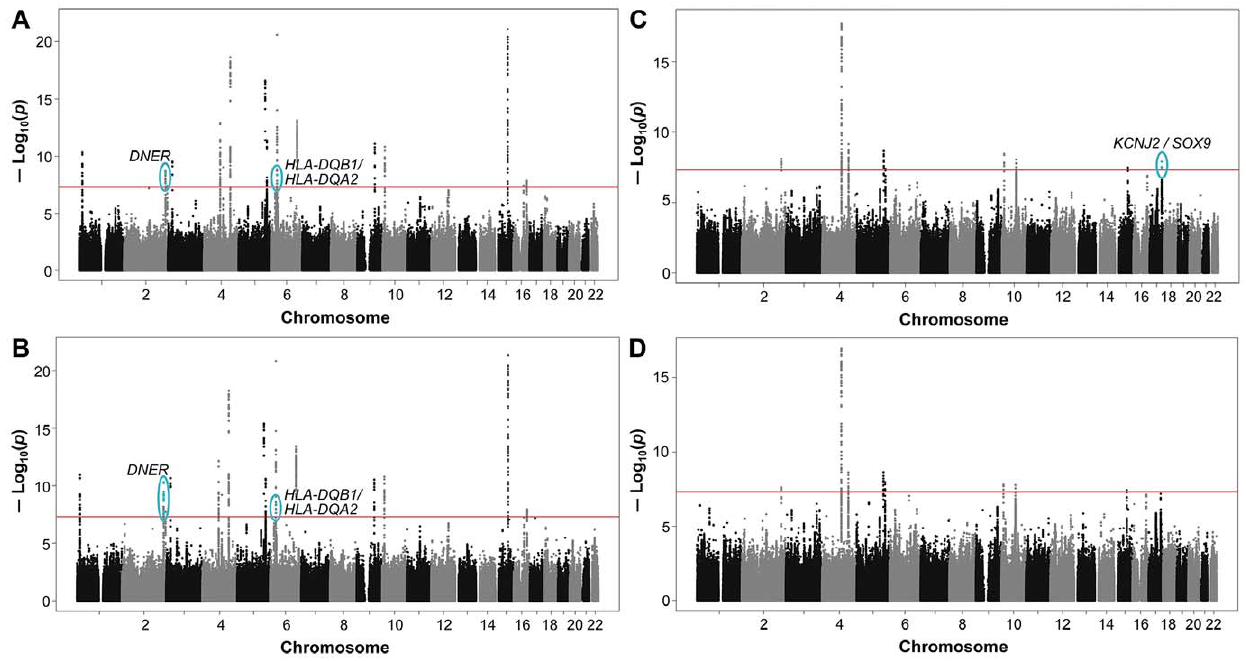
Figure 1. Genome-wide joint meta-analysis (JMA) of SNP and SNP-by-smoking interaction in relation to pulmonary function. The Manhattan plots show the chromosomal position of SNPs in comparison to their 2 log 10 P JMA values. JMA results are shown for models with (A) SNP- by-ever-smoking interaction term in relation to FEV 1 /FVC, (B) SNP-by-pack-years interaction term in relation to FEV 1 /FVC, (C) SNP-by-ever-smoking interaction term in relation to FEV 1 , and (D) SNP-by-pack-years interaction term in relation to FEV 1 . SNPs located within previously implicated loci are shown, but these loci were not considered when identifying novel loci from the joint modeling of SNP main effects and smoking interactive effects. Novel loci on chromosomes 2, 6, and 17 (shown in blue and circled) were identified as those having SNPs with genome-wide significant P values at the standard threshold ( P , 5 6 10 2 8 as indicated by the solid red line). Names of the novel gene (or closest genes) are provided.